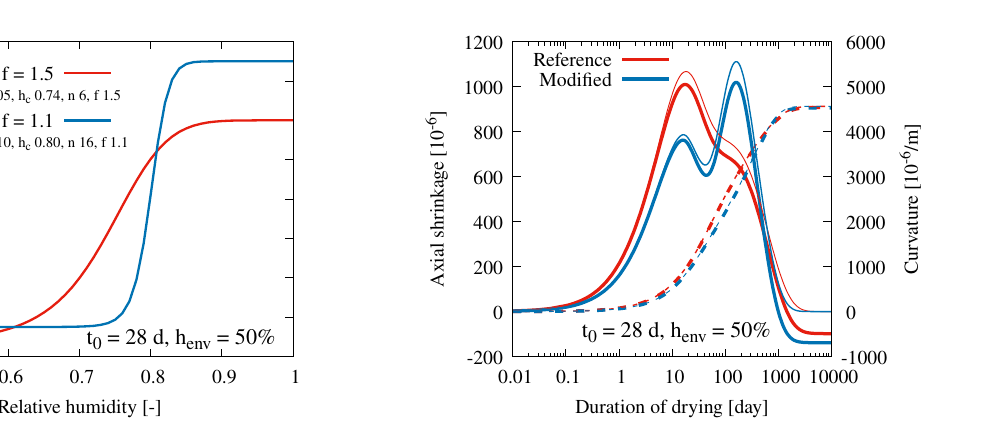
Figure 12. Di ff usivity function with the “reference” and “modified” set of material parameters.